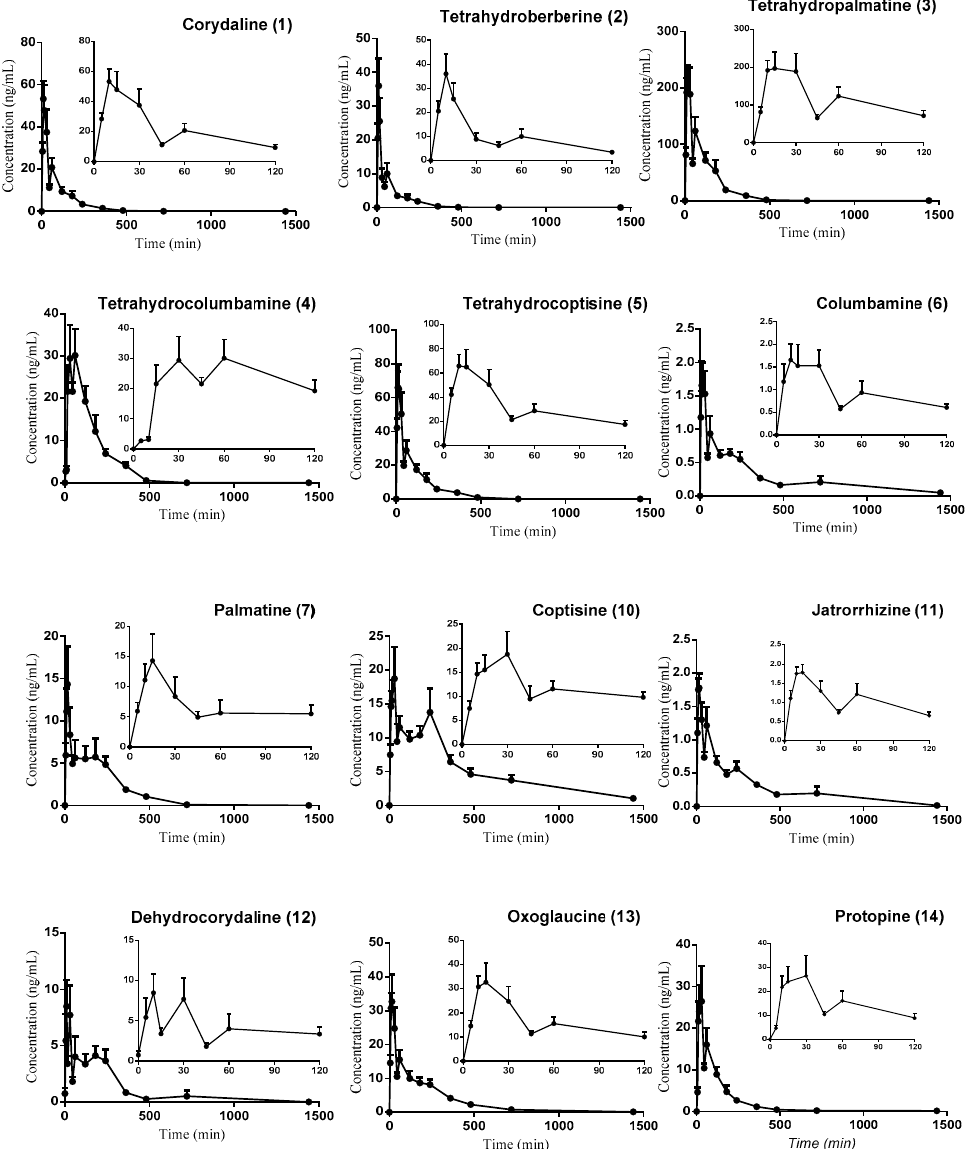
Figure 3. Mean plasma concentration-time profiles of twelve alkaloids after oral administration of Corydalis yanhusuo extract in male ICR mice (1.25 g/kg) (mean ± SEM).